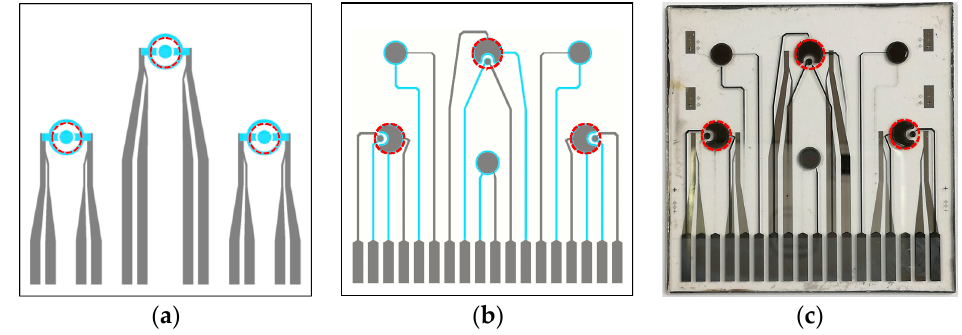
Figure 2. ( a ) Top view of the spatial positioning of the thin film heaters; ( b ) Top view of the spatial positioning of the photosensors (moon-like shape) and temperature sensors (small circular shape) aligned with the heaters; ( c ) Picture of the fabricated device (a-Si:H sensor side). The red dashed circles indicate the active area of the BL